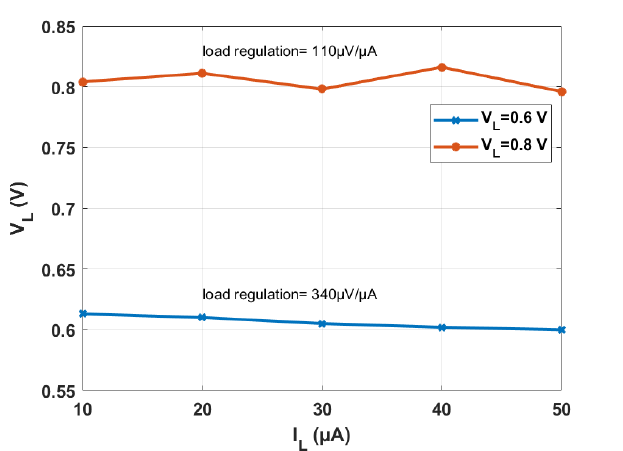
Figure 12. Load regulation of SI boost regulator at V TEG = 65 mV.